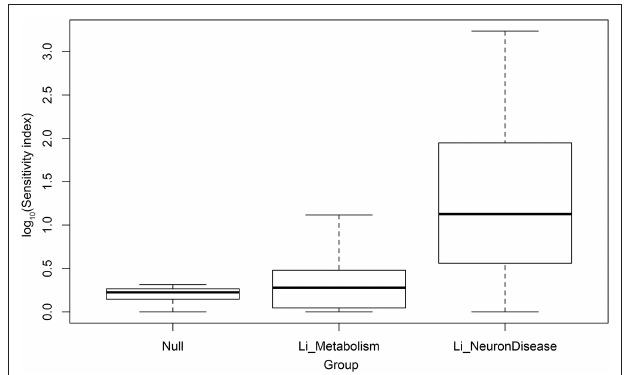
FIGURE 2 | Log 10 of sensitivity index of lithium-sensitive interactome for null sets, metabolic pathways, and pathways associated with disease of the nervous